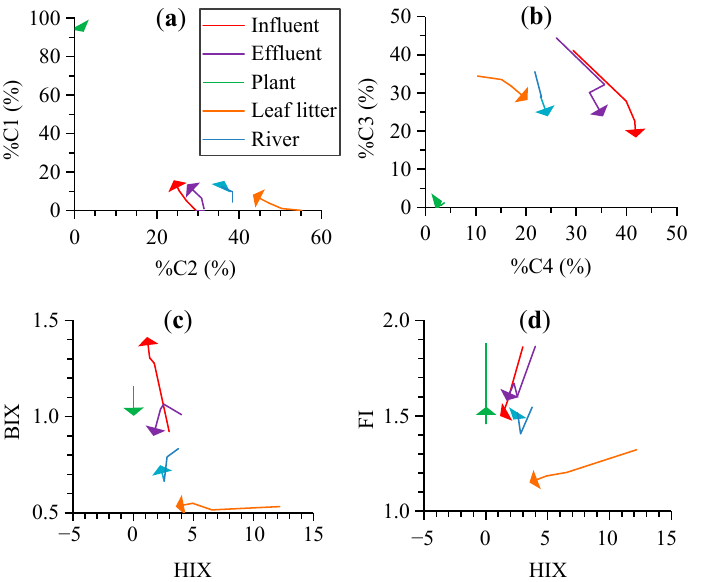
Figure 4. Changes in the fluorescence indices for the chemical composition of DOM by photodegra- dation (( a , b ): %C1–%C4; ( c , d ): HIX, BIX, and FI), with the triangles at the end of the lines showing the direction of changes.